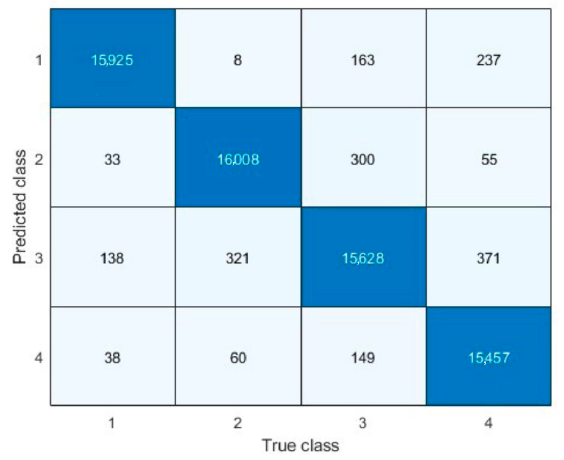
Figure 7. Confusion